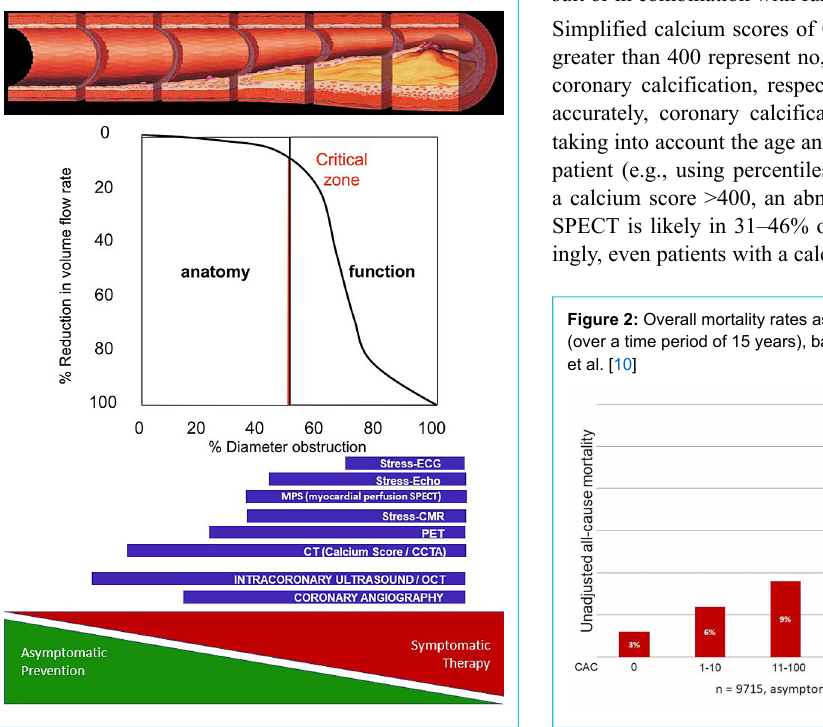
Figure 1: The slow progression of atherosclerosis and the devel- opment of coronary artery stenosis is shown in the upper part of the figure. As long as the coronary artery narrowing is less than 50%, there is no flow limitation. In stenoses of more than 50%, flow limitation starts and there is a decrease of flow. In the lower part of the figure, the diagnostic modalities are shown, which can be used to evaluate the different stages of the ischaemic cascade. Adapted from [5].CCTA = coronary computed tomographic angiog- raphy; CMR = cardiac magnetic resonance imaging; ECG = elec- trocardiogram; OCT = optical coherence tomography; PET =